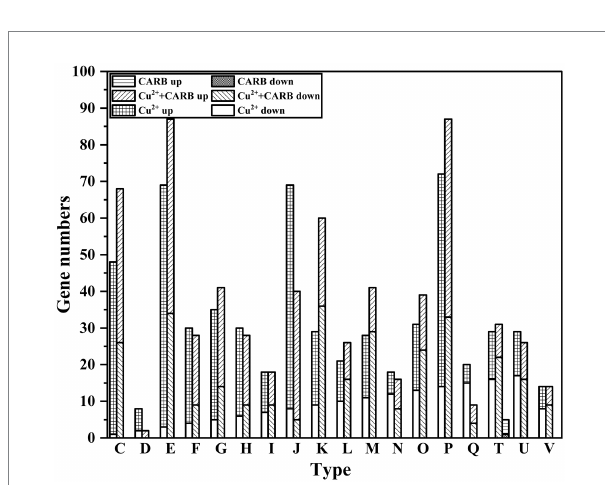
FIGURE 8 COG annotation information. C: Energy production and